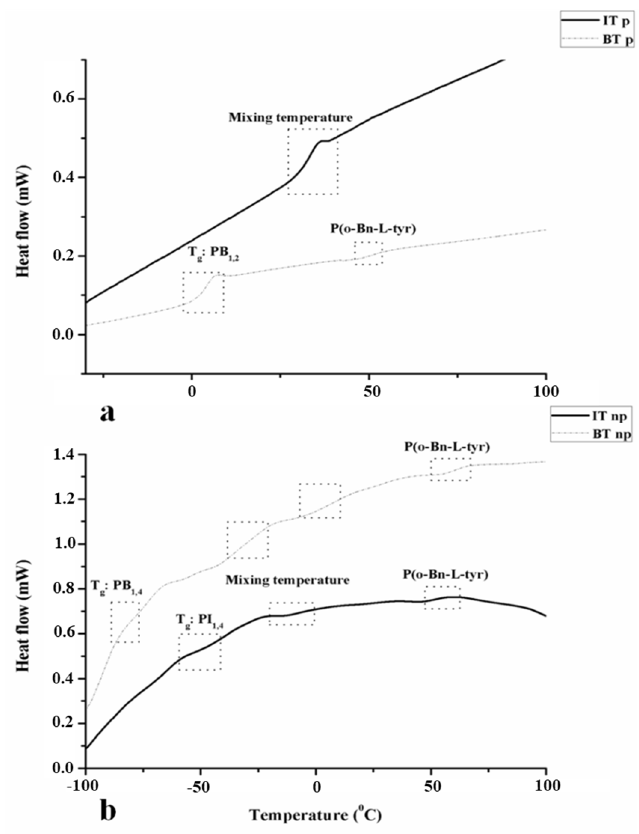
Figure 6. DSC thermographs of all synthesized hybrid materials are presented. In ( a ), the glass transition temperatures for both PI 1,4 - b -P(o-Bn-L-Tyr) (solid line) and PB 1,4 - b -P(o-Bn-L-Tyr) (dashed line) are obvious, as well as in ( b ) the glass transition temperatures for PI 3,4/1,2 - b -P(o-Bn-L-Tyr) (solid line) and PB 1,2 - b -P(o-Bn-L-Tyr) (dashed line).